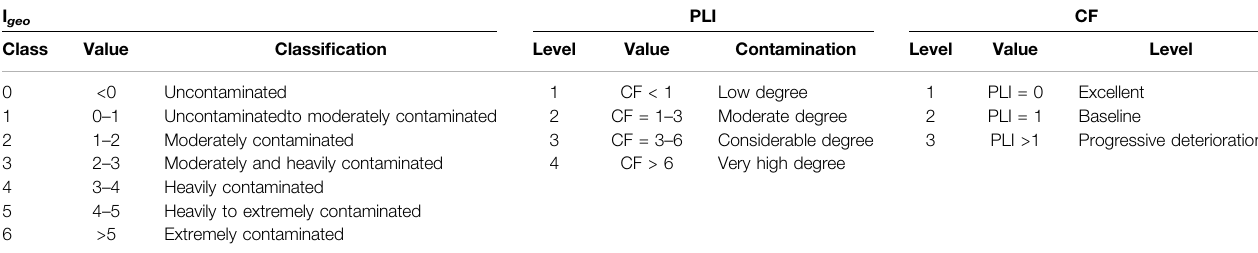
TABLE 3 | Contamination categories based on a geo-accumulation index (I geo ), pollution load index (PLI), and contamination factor (CF).